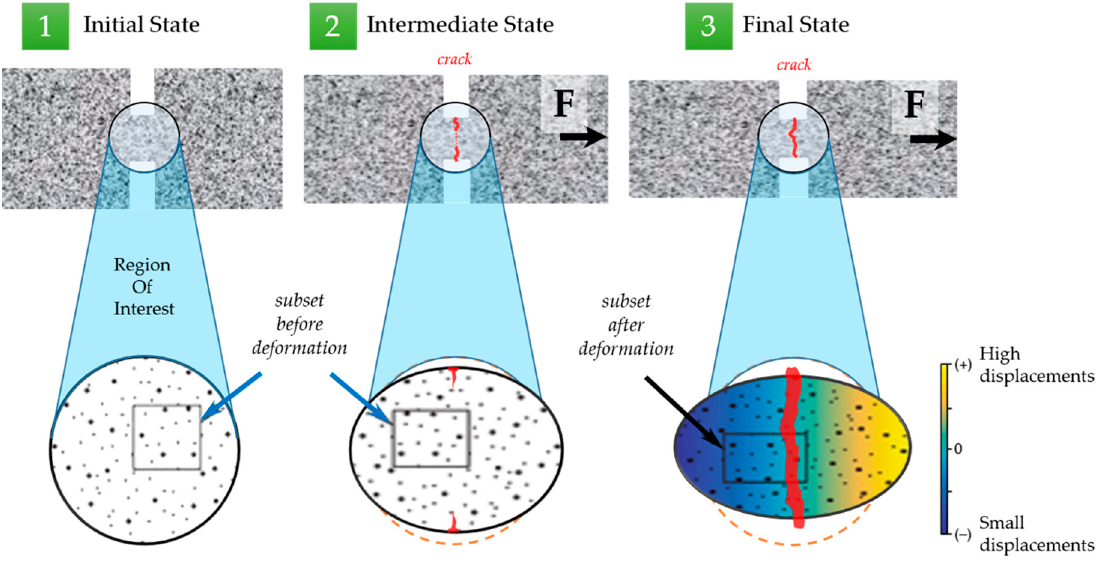
Figure 13. The pattern quality of the captured SEM images.